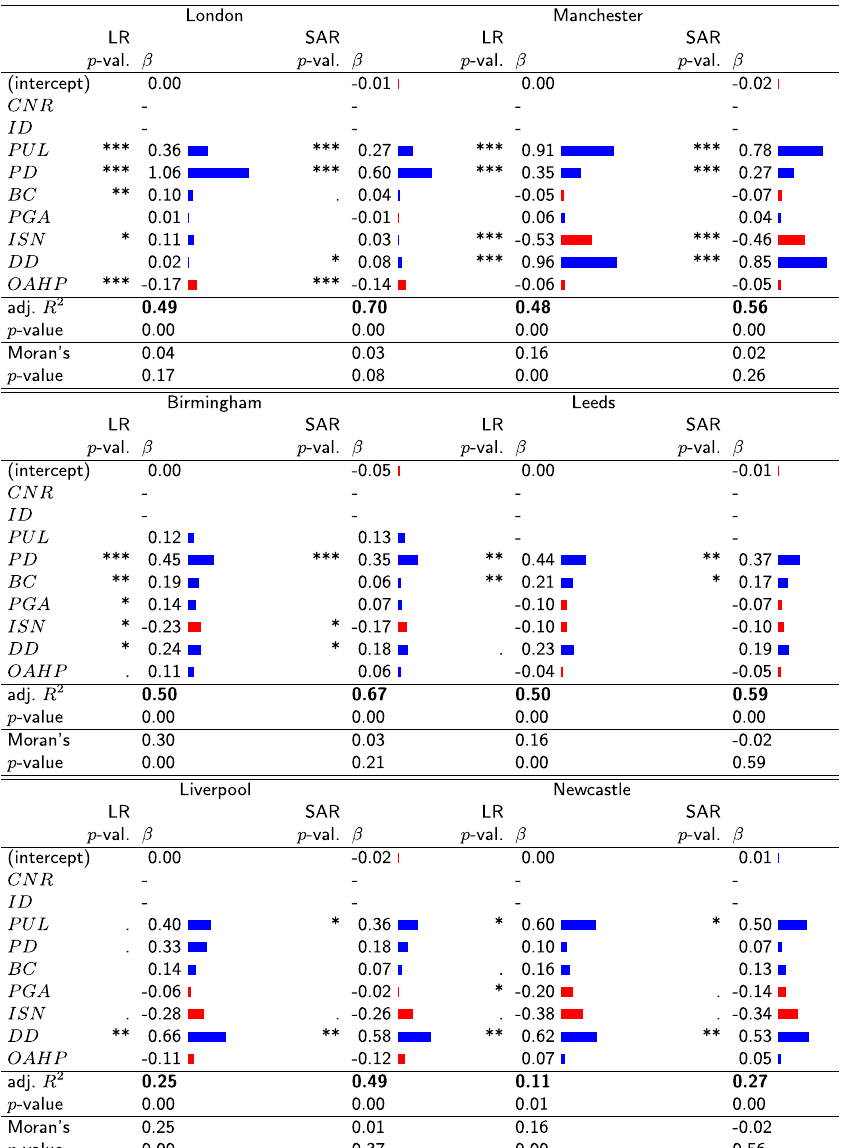
Table 3 LR and SAR models for the six urban areas under study with outcomes of the Moran’s